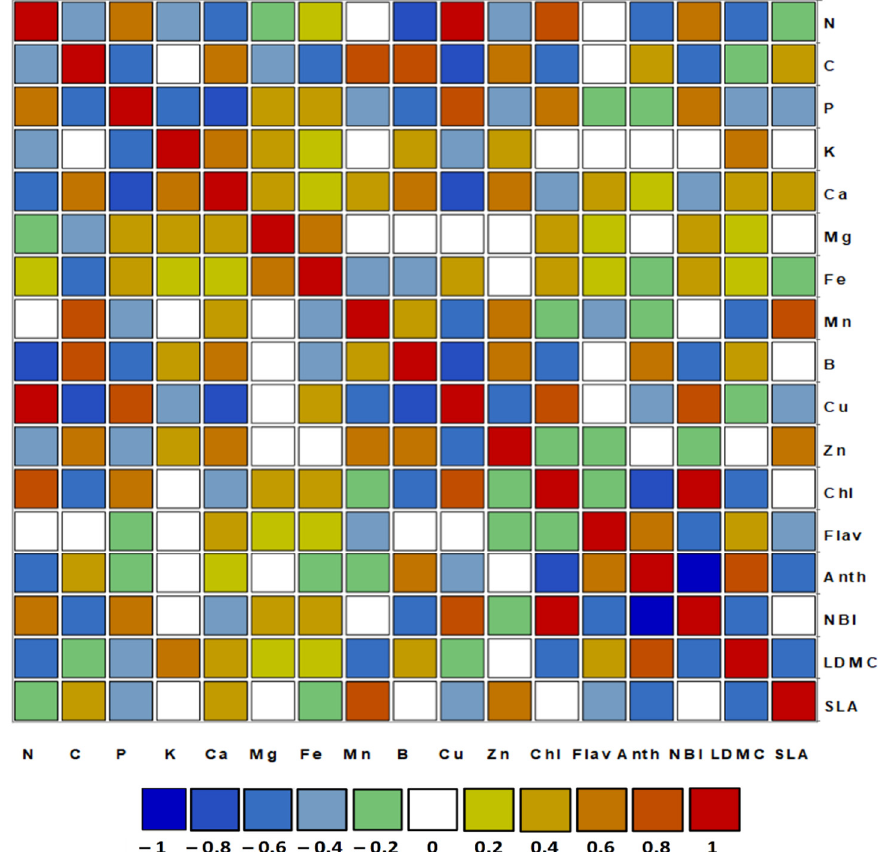
Figure 2. Heatmap of Pearson’s correlation among the analyzed variables. Data from leaf diagnostics, content of total chlorophyll, flavonol, anthocyanin and nitrogen balance index and leaf biometrics recorded at 90 DAFB were compared. Positive correlations with high values as well as self-correlations are red colored while negative ones are blue colored. The other levels of correlations are indicated with different shades of colors according to the figure caption. Numerical values and the significance of correlations are shown in Supplemental Table S1. (Level of correlation: 1.0–0.8, very high; 0.8–0.6, high; 0.6–0.4, moderate; 0.4–0.2, low; 0.2–0, negligible correlation). K at 90 DABF showed only one positive correlation with Ca of a moderate level